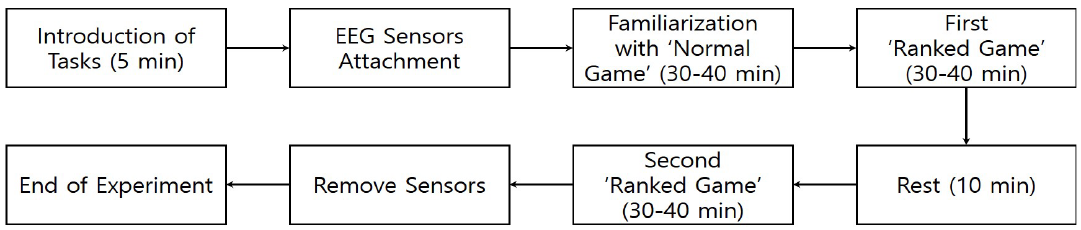
Figure 2. Experimental process.